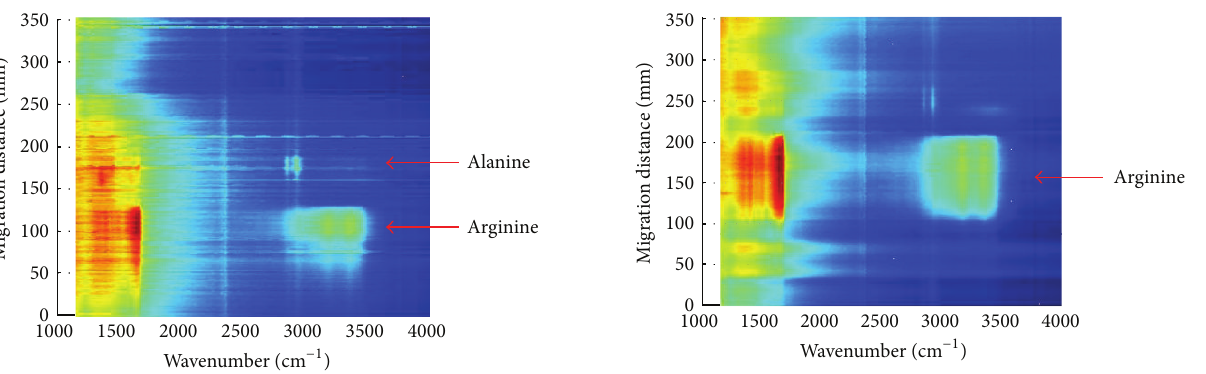
Figure 1: 3D chromatograph to characterize the distribution of arginine and alanine spots on a narrow band TLC plate.